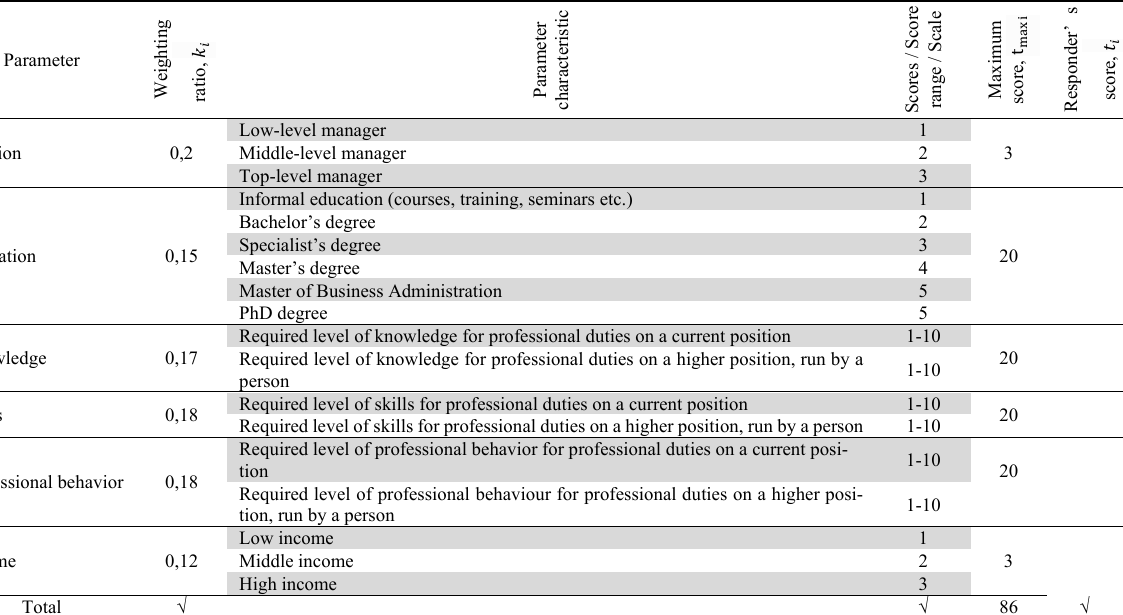
StA personal parameters estimation